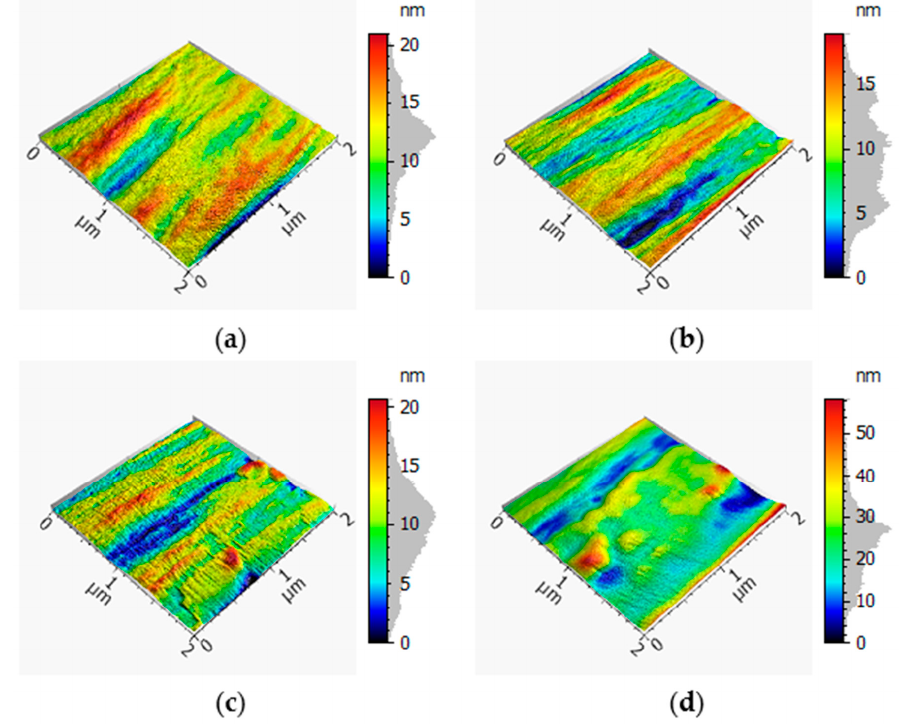
Figure 3. 3D, 2 µ m × 2 µ m surface profile of ( a ) the reference fiber, ( b ) the reference without the sizing agent, ( c ) a fiber detached with a power output of 66% and ( d ) a fiber detached from the treated sample with a power output of